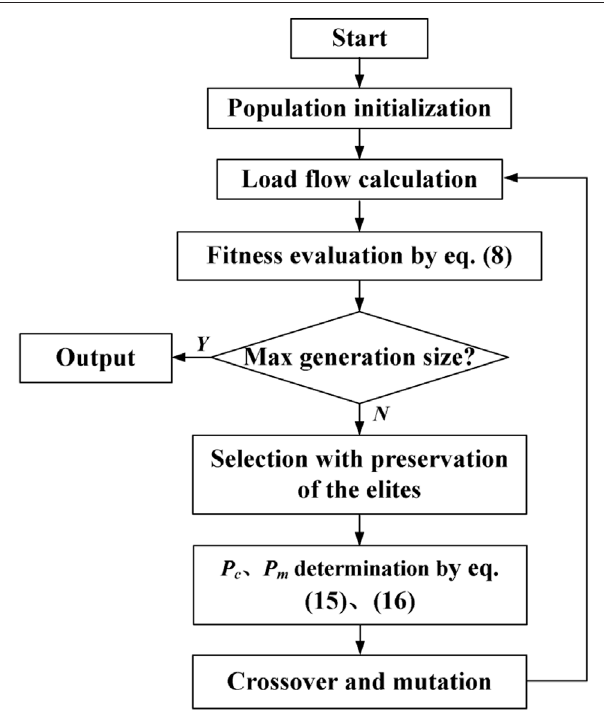
FIGURE 8 | Flowchart of the optimizing process via the developed GA with